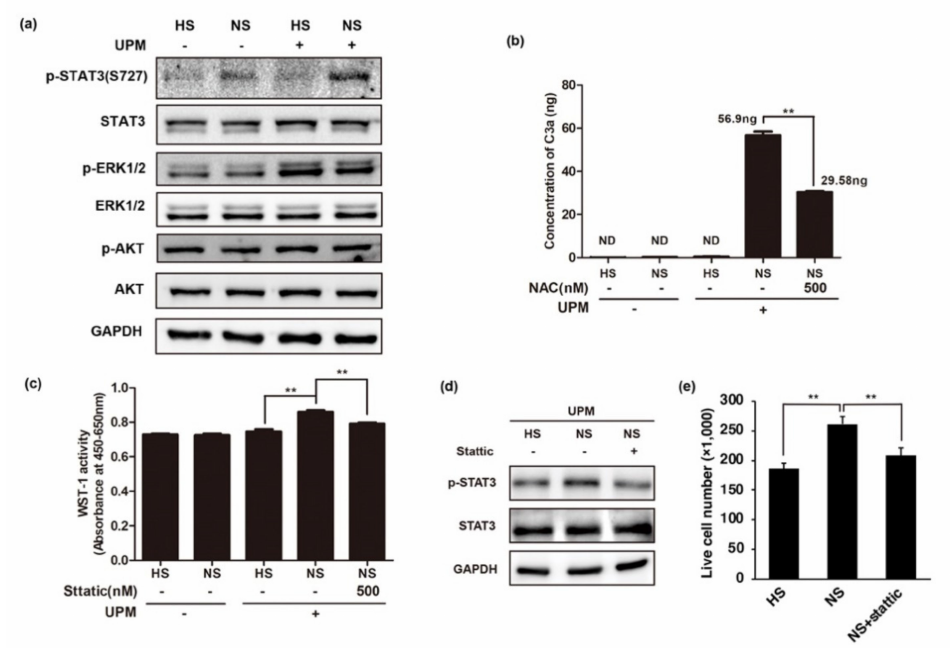
Figure 5. Complement activation provides survival benefit in UPM-treated HUVECs by inducing STAT3 phosphorylation. ( a ) Western blot for complement activation-related signaling proteins. UPM- treated HUVECs were incubated with heated human serum or normal human serum for 48 h. Each indicated protein was analyzed with cell lysate using Western blotting. ( b ) Analysis of C3a in the culture supernatant from UPM-treated HUVECs with human serum. The culture supernatant from UPM-treated HUVECs with HS or NS was collected, and C3a was analyzed by ELISA. One hour before the serum was added, NAC was applied to UPM-treated HUVECs. Results are shown as mean ± SD, n = 3, Two-way ANOVA and multiple comparisons. ** p < 0.01. ( c ) STAT3 inhibitor, stattic, attenuated the complement activation-mediated survival benefit of UPM-treated HUVECs. The same number of cells were seeded onto a 96-well culture plate. HUVECs were treated with UPM for 24 h, followed by the indicated HS or NS for 1 h. Cells were treated with stattic 2 h before human serum treatment. HS or NS was applied for 1 h, and the culture medium was changed into fresh medium. After incubation for 48 h, cell viability was measured using the WST-1 assay. Results are shown as mean ± SD, n = 5, two-way ANOVA and multiple comparisons. ** p < 0.01. ( d ) Western blot for p -STAT with a specific inhibitor, stattic (500 nM). ( e ) Analysis of live cell numbers of HUVECs with UPM-mediated complement activation. Stattic was applied at 500 nM. Trypan blue exclusion assay was applied to cell count at 48 h after exposure of UPM. One-way ANOVA. Results are shown as mean ± SD, n = 3, ** p <